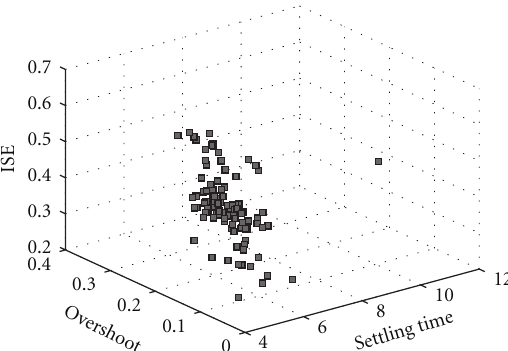
Figure 7: Multiobjective optimization the Pareto sets of the G 2 ( s ) plant.